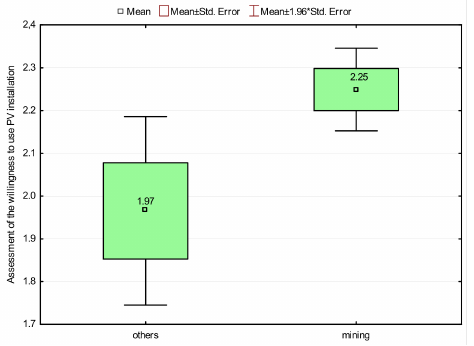
Figure 9. Which sectors of the economy are most affected by the decarbonization policy (mining) vs. assessment of the willingness to use PV installations?